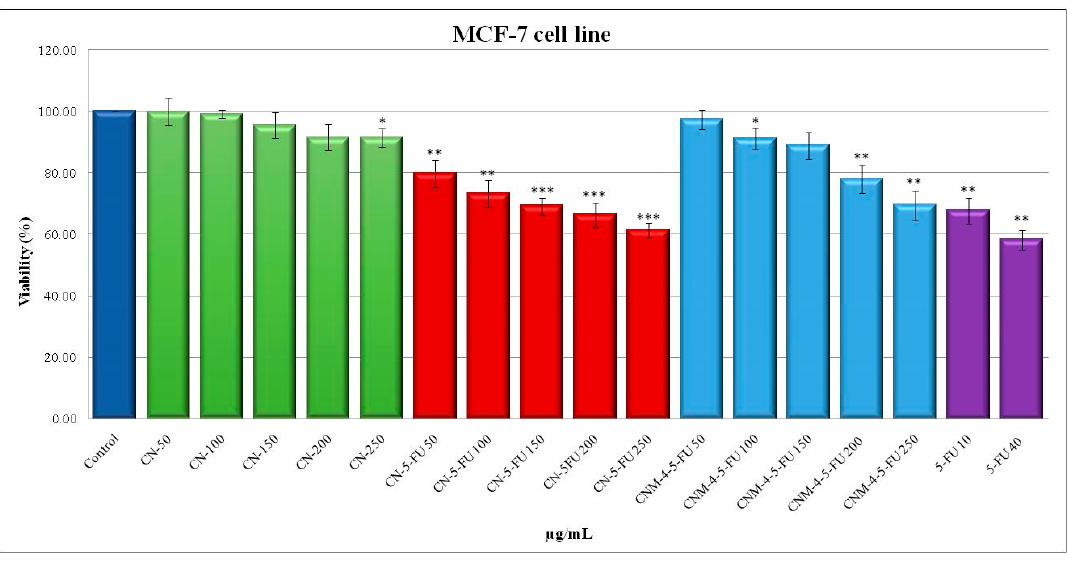
Figure 11. Viability of human breast carcinoma MCF-7 cells after 48 h incubation with non-loaded nanocapsules (CN-2), 5-FU-loaded nanocapsules (CN-2-5-FU), 5-FU-loaded magnetic nanocapsules (CNM-4-5-FU), and 5-FU as a function of concentration (Student’s t test: * p < 0.05; ** p < 0.01; *** p <